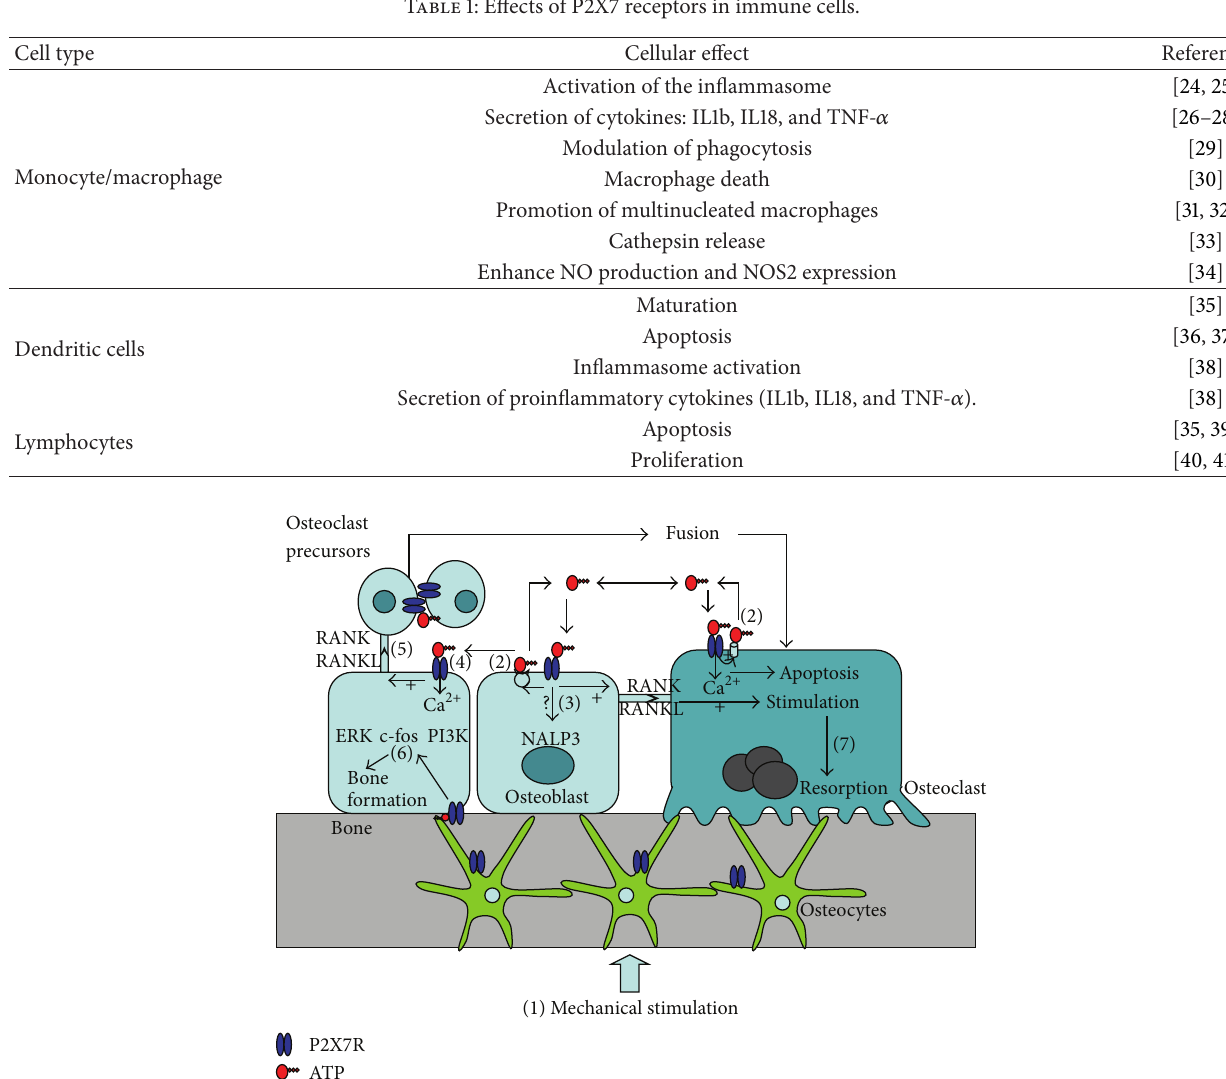
Figure 1: The physiological functions of the P2X7 receptor in bone cells. Numbers in brackets refer to published cellular functions associated with P2X7 receptor activation and/or expression. (1) Mechanostimulation induces ATP release. (2) Modulation of ATP release by the P2X7 receptor. ATP release from osteoblasts involves vesicular exocytosis. In osteoclasts, ATP release is associated with P2X7 activation, but the exact mechanism has not yet been determined. (3) Osteoblasts may be a source of local cytokine release possibly through the P2X7 inflammasome pathway. (4) ATP is released from osteoblasts upon mechanical and nucleotide stimulation and mediates paracrine signalling to neighboring cells via P2X7 receptor activation. (5) P2X7 receptor activation induces RANKL expression in osteoblasts and subsequently formation of osteoclasts from mononuclear precursors. (6) P2X7 receptors activation is coupled to intracellular signalling pathways in osteoblasts that induce cell growth and bone formation. (7) In osteoclasts, P2X7 receptor activation is linked to fusion of mononuclear osteoclast precursors and to apoptosis and cell survival hand to activation of osteoclastic bone